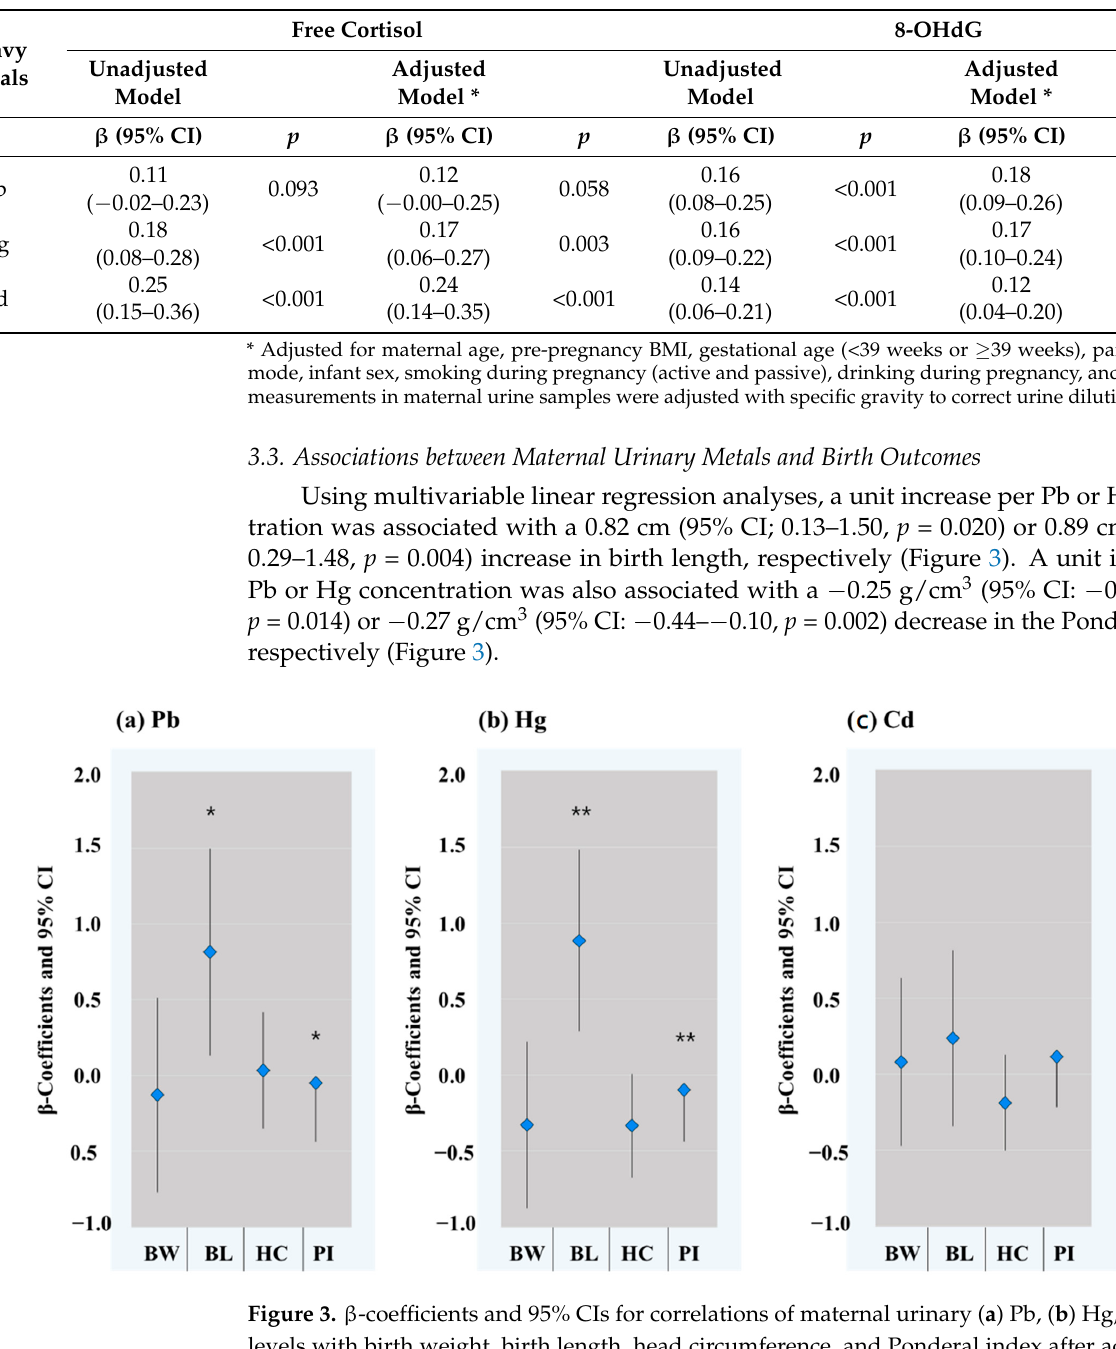
Table 3. Multiple linear regression coefficients (95% CI) between biomarkers and neonatal anthro ‐